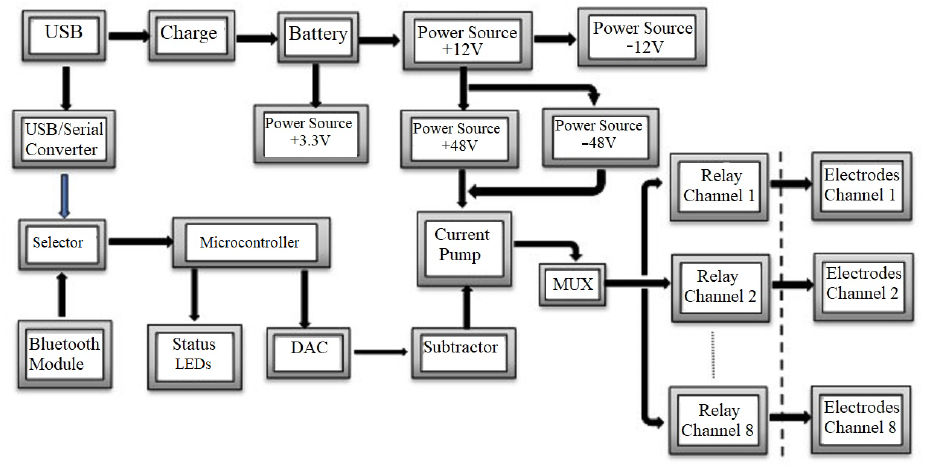
Figure 3. Block diagram of the STIMGRASP